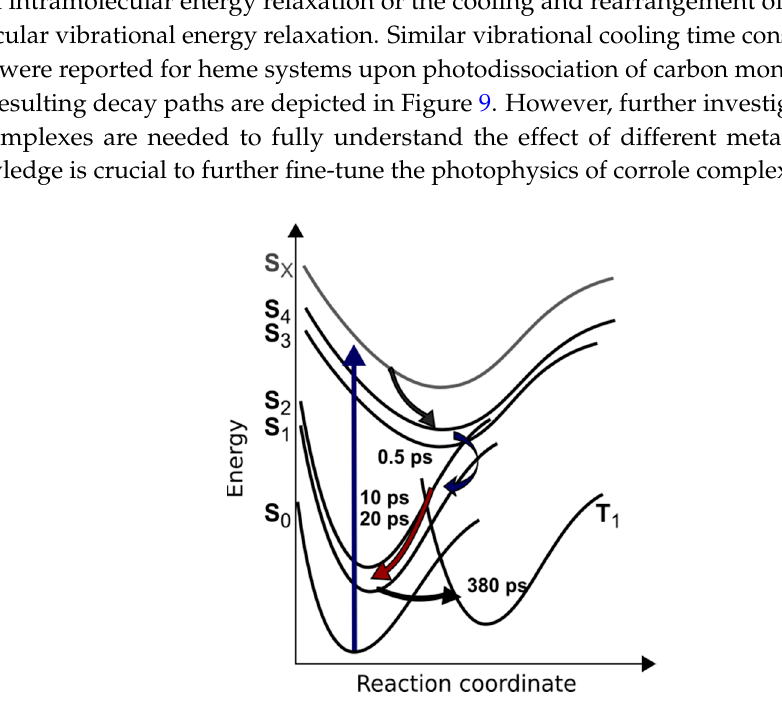
Figure 9. Photoreaction pathway of Sb-tpfc-F 2 after excitation with a 400 nm pulse at the high energy side of the Soret band. Arrows indicate internal conversion from the Soret to Q band on a short time scale of 0.5 ps, with subsequent cooling processes on time scales of 10 ps and 20 ps. Intersystem crossing from the S 1 state to the T 1 state was observed with a time constant of 400 ps.